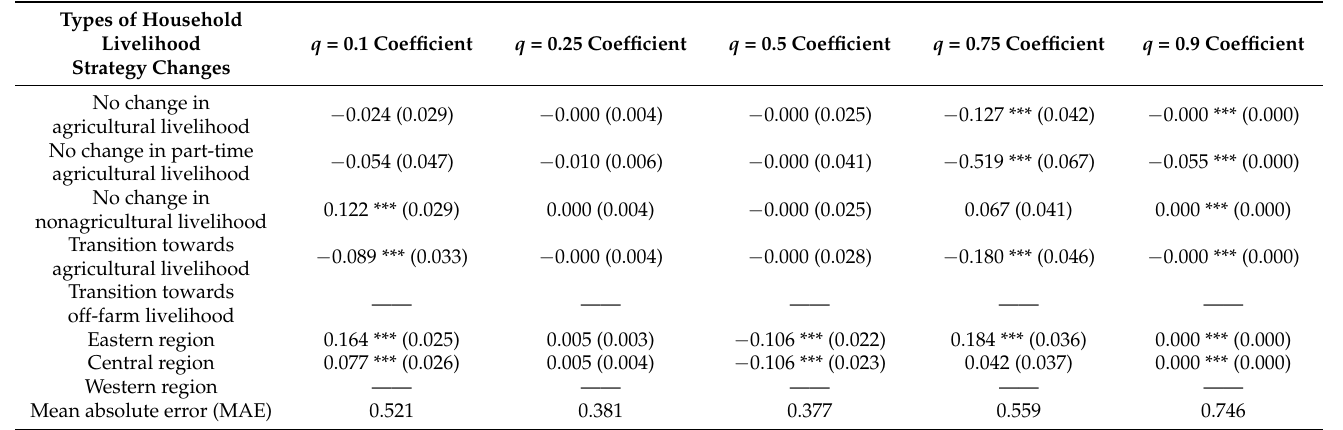
Table 7. Quantile regression of the agricultural diversification index on changes in household livelihood